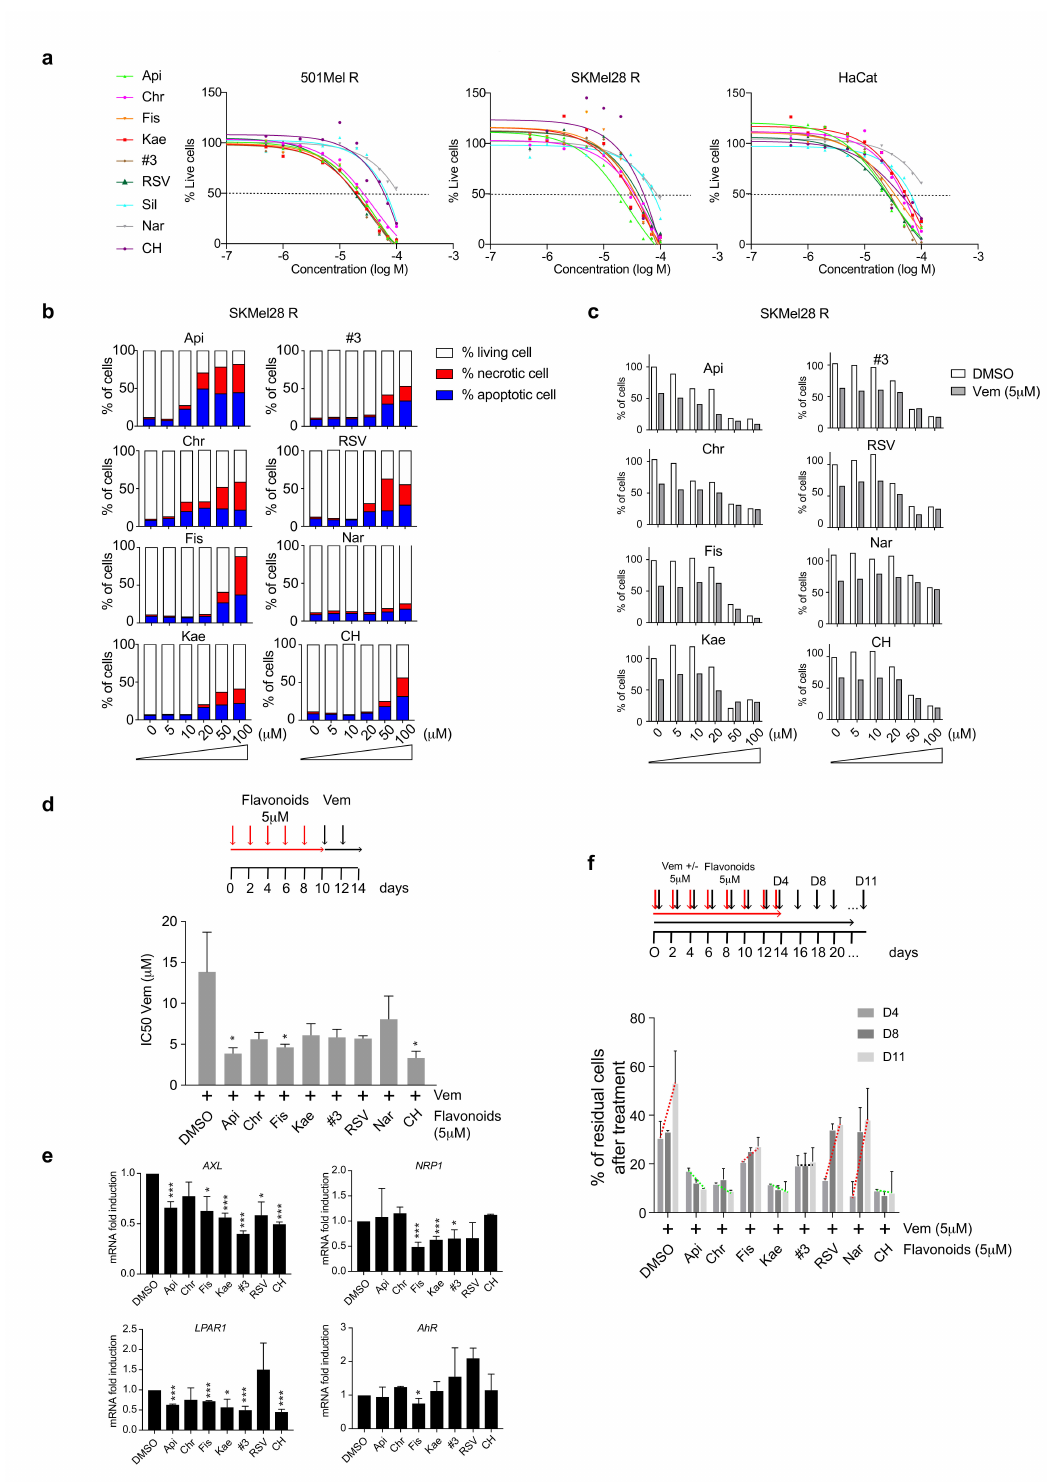
Figure 3. Flavonoids sensitize melanoma cells during BRAFi treatment ( a ) 501MelR, SKMel28R (BRAFi-resistant), and HaCat keratinocyte cells were treated for 48 h with increasing concentrations of flavonoids (0 to 100 µ M). Cell density was evaluated by methylene-blue staining followed by